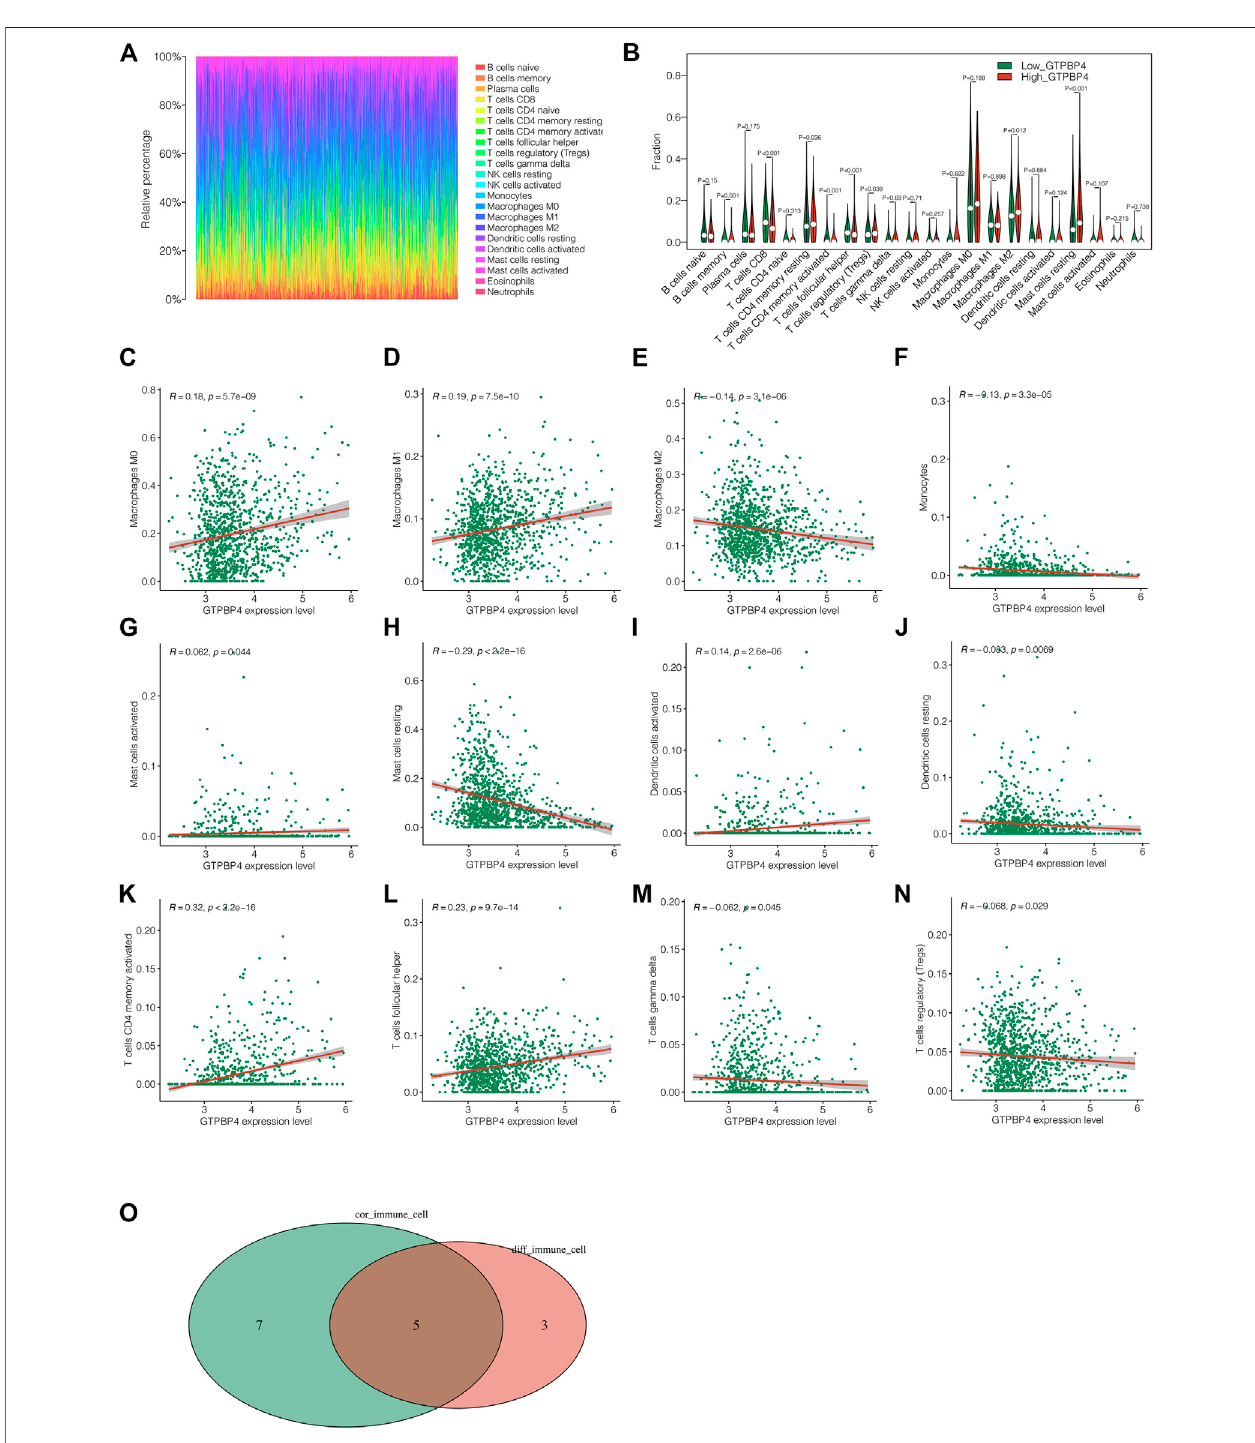
FIGURE 7 | Analysis of immune microenvironment. (A) Immune landscape of breast cancer. We can see the proportion of different immune cell types. (B) The differences in immune cell in fi ltration levels between the high GTPBP4 expression group and the low GTPBP4 expression group, and 8 different immune cells were obtained (C – N) Correlation analysis showed that 12 kinds of immune cells were signi fi cantly correlated with GTPBP4 (O) Five most signi fi cant immune cell types were obtained by intersection of 8 different immune cell types and 12 related immune cell types.